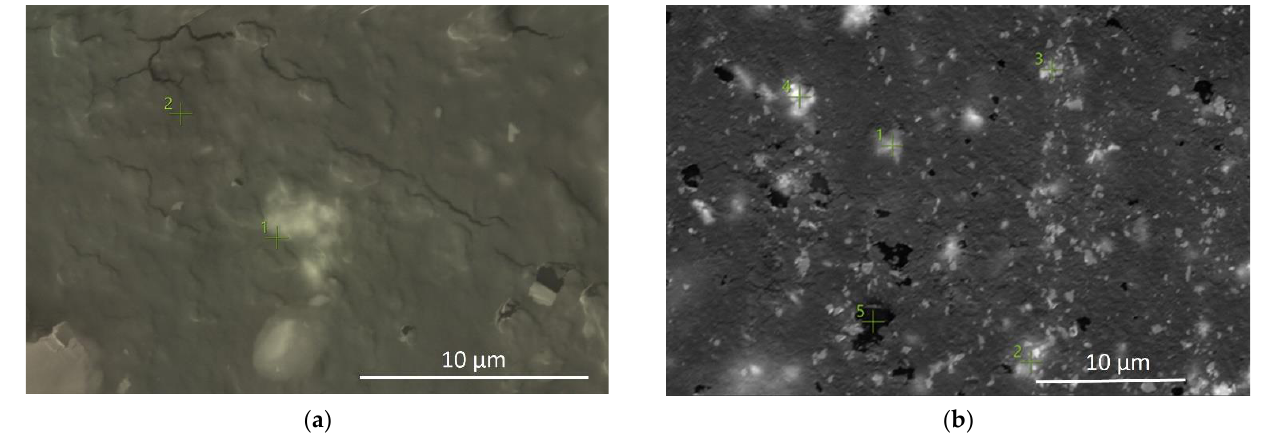
Figure 5. ( a ) SEM backscatter imagery of 1% ZnO sample with EDS inspection points at markers. ( b ) EDS analysis of 5% ZnO sample validating voids and ZnO agglomerations.